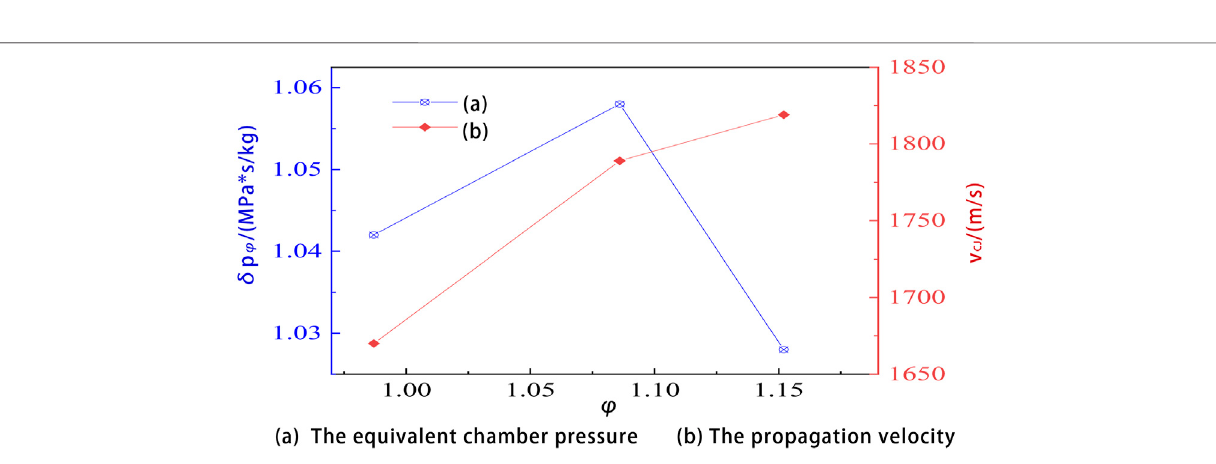
Frontiers in Energy Research |